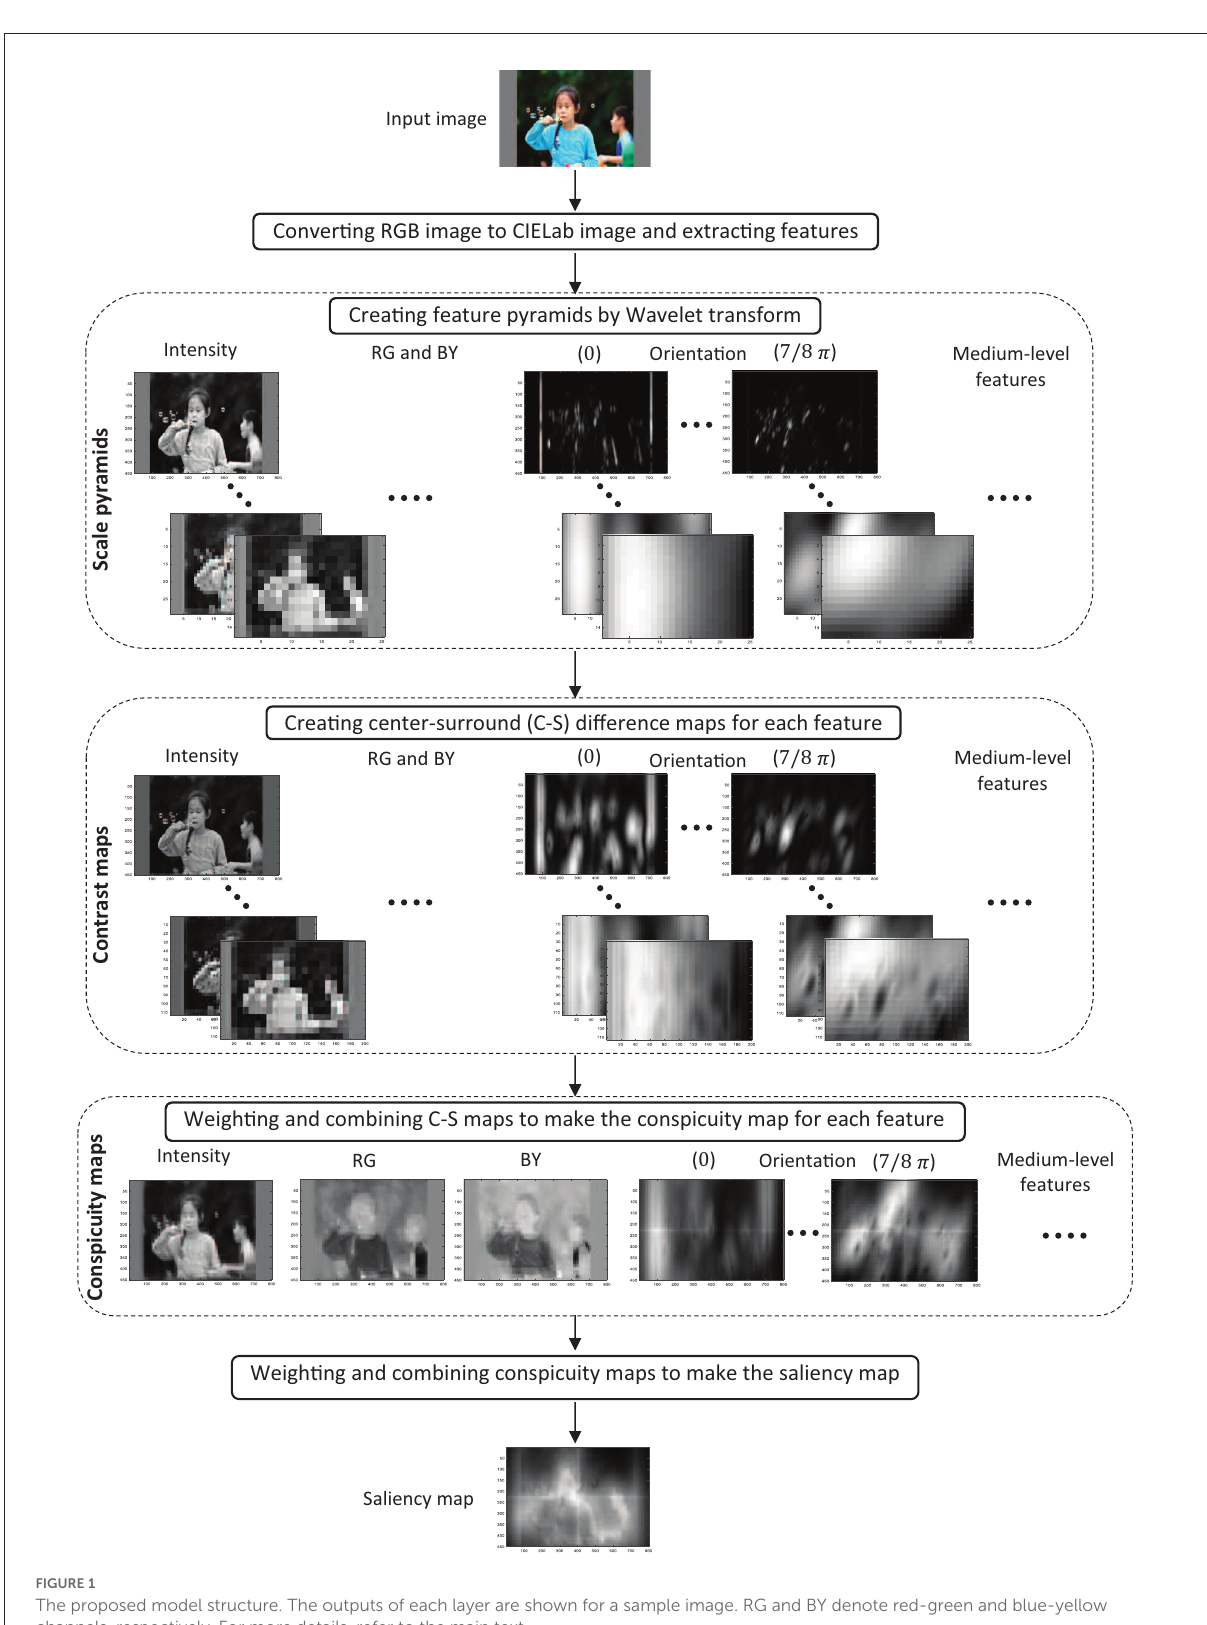
FIGURE1 The proposed model structure. The outputs of each layer are shown for a sample image. RG and BY denote red-green and blue-yellow channels, respectively. For more details, refer to the main